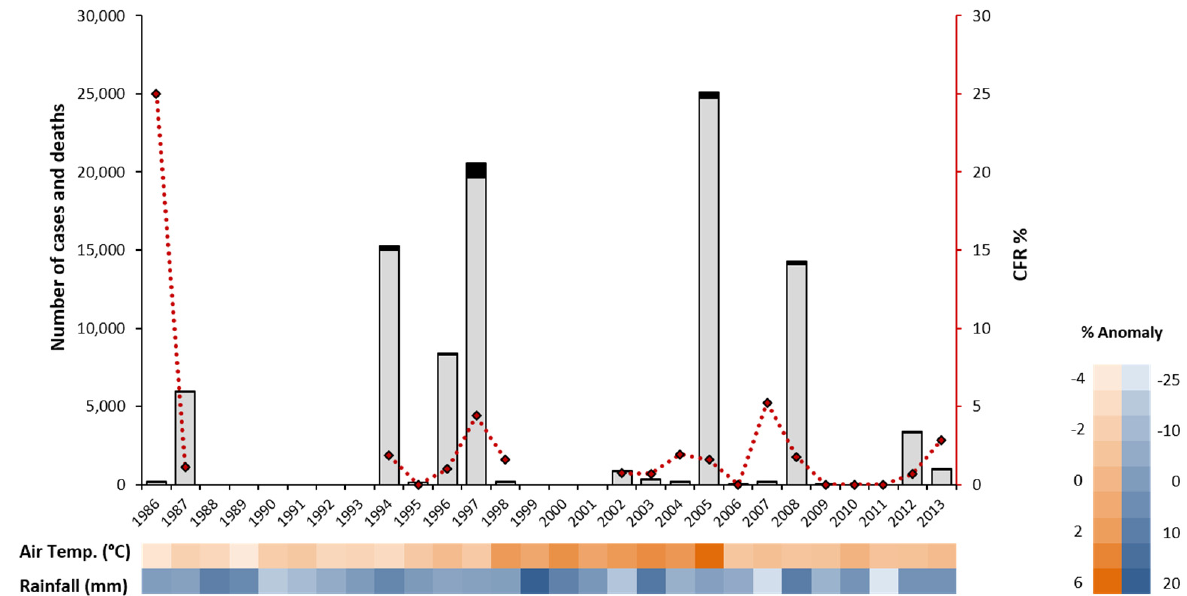
Figure 1. Number of cholera cases, deaths, and case fatality rate (CFR) in Guinea-Bissau between 1986 and 2013, from the WHO weekly epidemiological reports. Bar height corresponds to the total number of cholera cases reported; black portion of the bars corresponds to number of deaths. The red dashed line corresponds to the CFR percentage. Heat map (ascending color gradient) showing air temperature (orange, annual average range 27.69–30.57 °C) and rainfall (blue, annual average range, 844–1345 mm) deviation to the 27-year time series average.